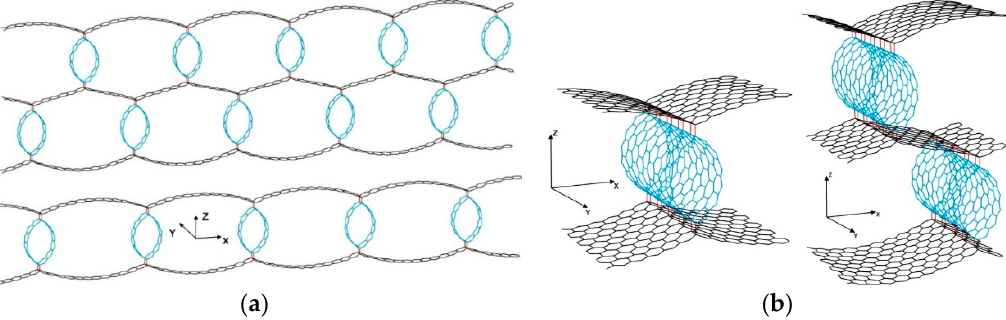
Figure 2. Atomistic models of graphene–CNT composite films with CNT (12,0) and an inter-tube distance of 12 hexagons used to simulate bending deformation in two directions: ( a ) perpendicular to CNTs; ( b ) along CNT axis.